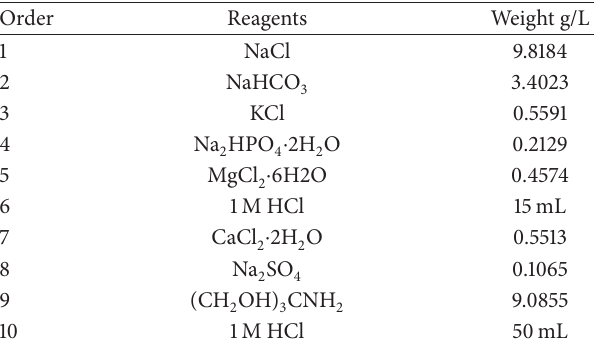
Table 1: Components of 1.5x Tas-SBF [10].